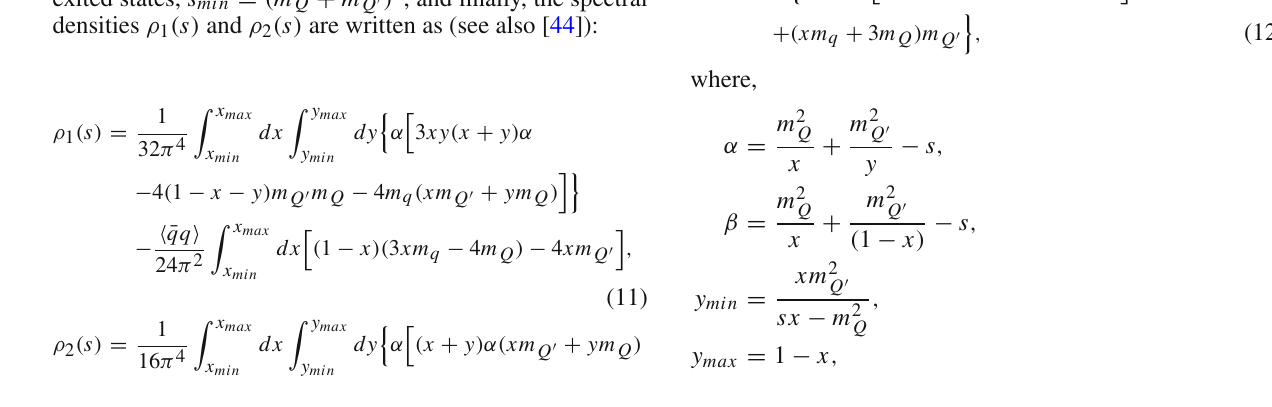
(cid:6) ( s ) , where i = 1 ( 2 ) is related to the structures / pg μν 1 i π Im and g μν . Further, s 0 is the continuum threshold, which is not fully arbitrary and it is associated with the energy of the exited states, s min = ( m Q + m Q (cid:3) ) 2 , and finally, the spectral densities ρ 1 ( s ) and ρ 2 ( s ) are written as (see also